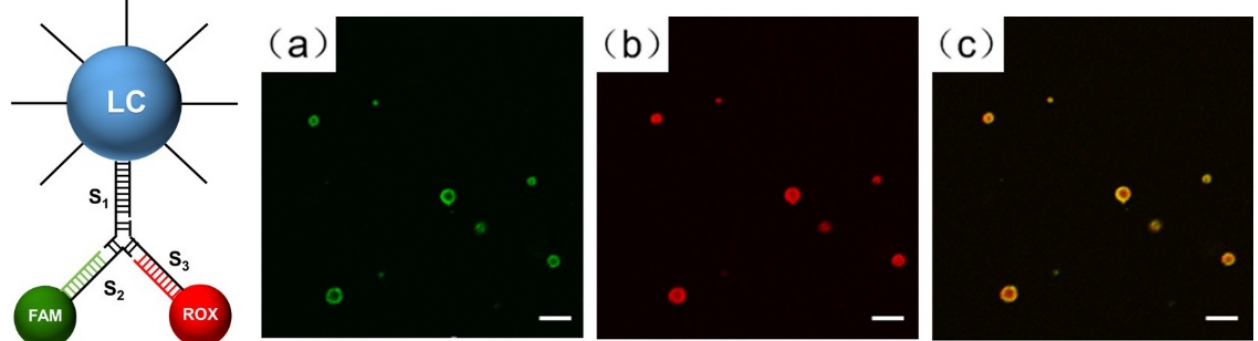
Figure 3. Schematic representation and the confocal images of LC droplets modified by DNA ‐ C18 and hybridized with FAM ‐ and ROX ‐ labeled DNA strands: ( a ) green channel, ( b ) red channel, and ( c ) merged green/red channels. Scale bar is 10 μ m.